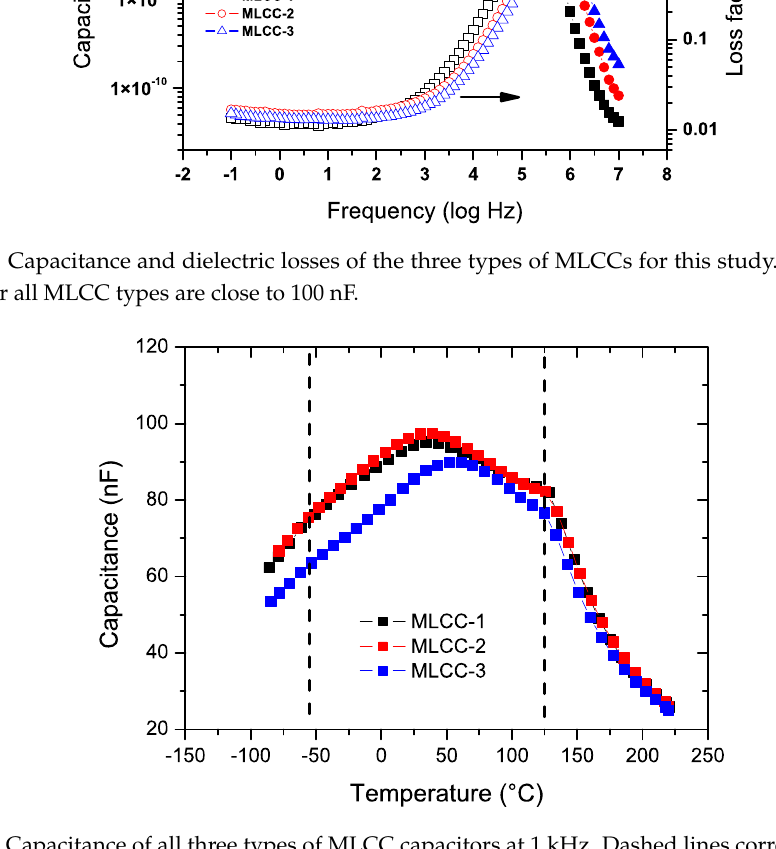
Figure 6. Capacitance of all three types of MLCC capacitors at 1 kHz. Dashed lines correspond to the X7R temperature specification limits.